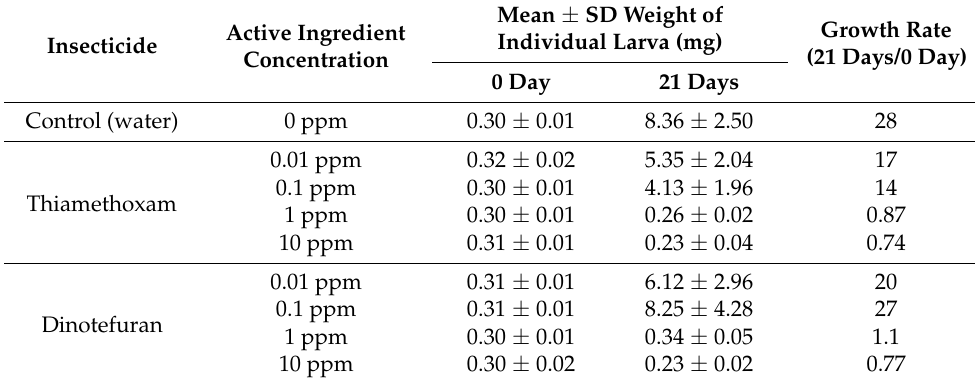
Table 1. Weight change of Aromia bungii neonates in the dietary toxicity test.